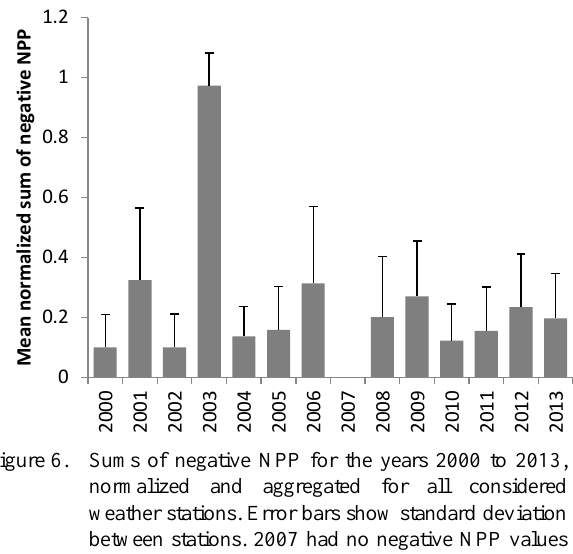
Figure 6. Sums of negative NPP for the years 2000 to 2013, normalized and aggregated for all considered weather stations. Error bars show standard deviation between stations. 2007 had no negative NPP values at any station.